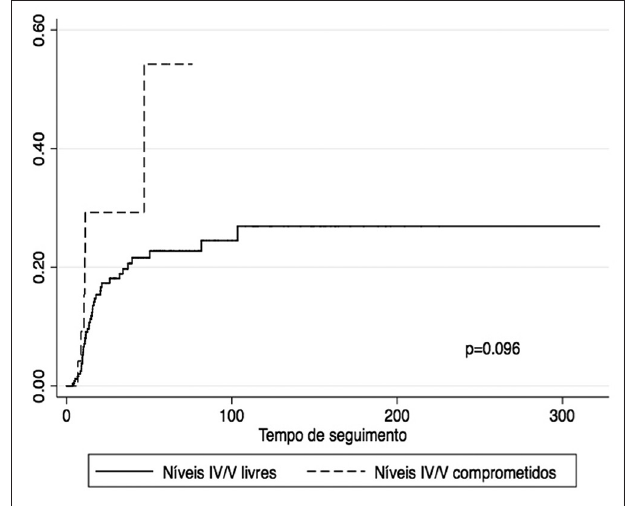
Figura 3. Curva de risco acumulativo de Nelson-Aalen para a ocor - rência de recidiva cervical pela presença de linfonodos metastáticos em nível IV/V.